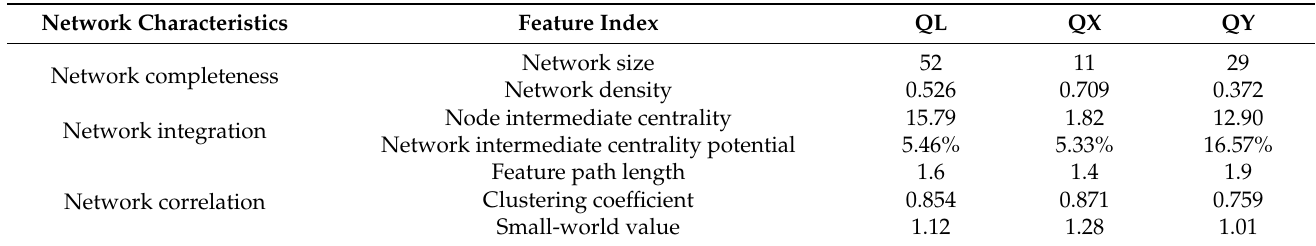
Table 5. Network feature parameter table for public spaces within affordable housing areas as typical samples. Network